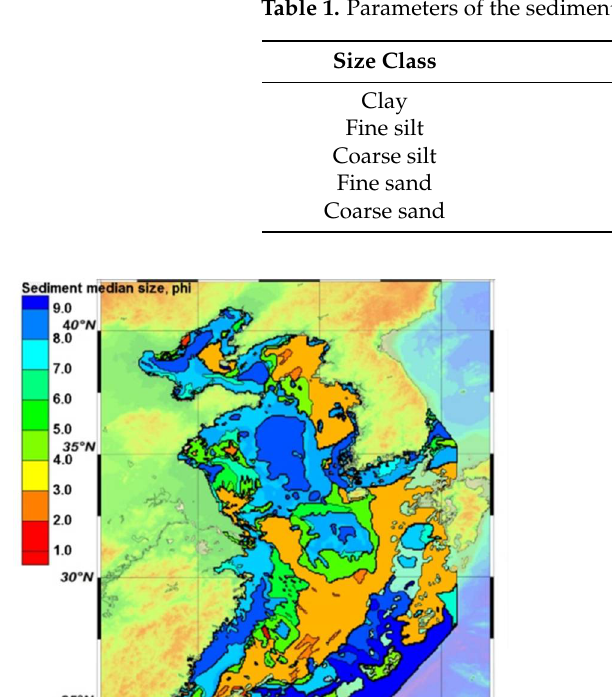
50 ; ( b ) distribution of mud